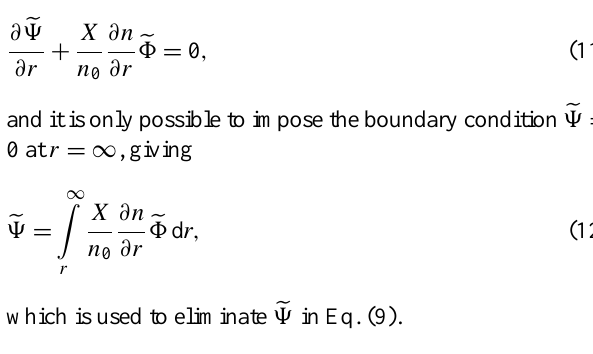
quencies (resonances) of the system (Eqs. 9–10) shown in Fig. 1b. For comparison, the spectrum for the Schrödinger equation (Eq. 13) is shown in Fig. 1c. The spectral peaks in Fig. 1a are closely aligned with the resonances correspond- ing to N = − 1 of the system (Eqs. 9)–(10) in Fig. 1b, as indi- cated by vertical lines. The spatial profiles of the radial eigen- modes for the azimuthal-mode number N = − 1 are shown in Fig. 1d–i. Eigenmodes with higher radial-mode numbers R correspond to higher eigenfrequencies (but below the am- bient UH frequency), they have larger number of extrema, their largest amplitude is at the outer edge of the striation, and they are less localized in space since their